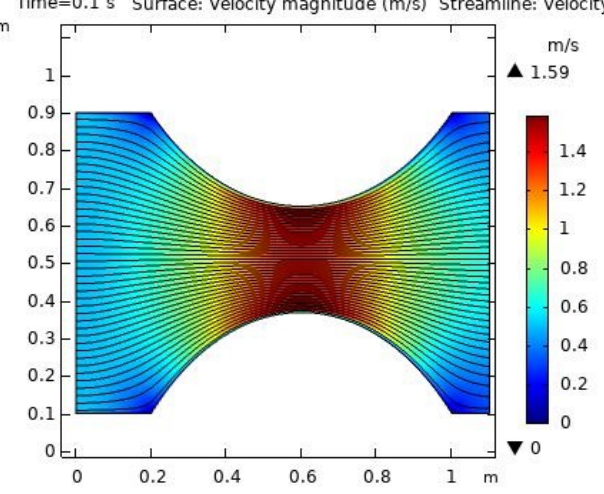
Figure 20. The streamlines at t = 0.1 s.